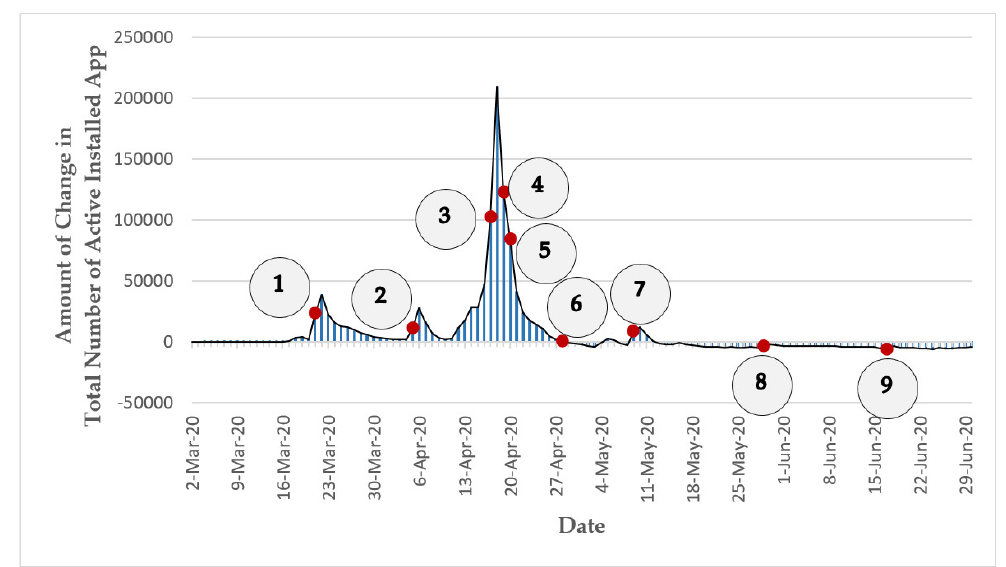
Figure 2. (1) Amount of change in the total number of active installed Mask apps (compared with the previous day) per day; (2) timeline of the identified television programs broadcasted by IRIB related to the Mask project and the endorsement, recommendation, or promotion of Mask project by the government (from 2 March to 30 June 2020). Notes: the figures for the amount of change in the total number of active installed Mask apps per day are limited to the installed instances of the Mask app downloaded from Cafe Bazaar Android marketplace; the numbering of the events is the same as that in Table 3.